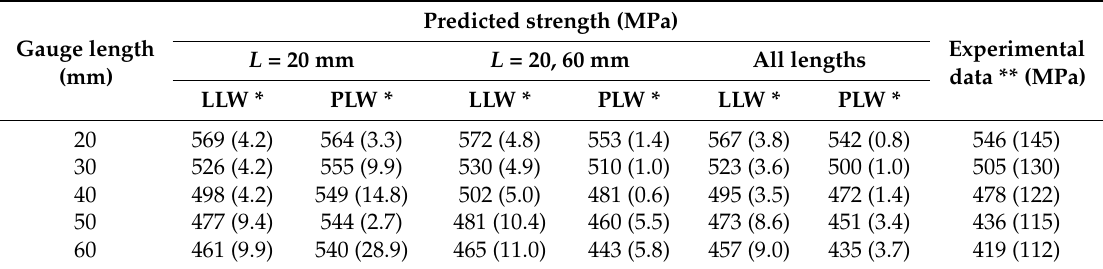
Table 3. Comparison of the predicted and experimental fiber strength at different gauge